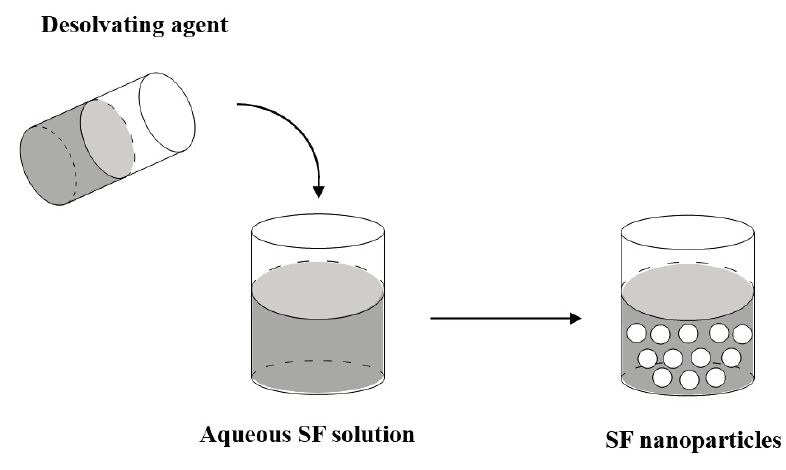
Figure 1. Schematic diagram of the desolvation method for preparing silk fibroin (SF) nanoparticles. Zhang et al. [45] reported the preparation of the SF nanoparticles by mixing the aqueous SF and water miscible protonic organic solvents (methanol, ethanol, propanol and isopropanol) or polar aprotonic organic solvents (tetrahydrofurnan and acetone). In this process, the regenerated SF molecules were instantly converted from Silk I into Silk II. When the aqueous SF was introduced rapidly into acetone, the water-insoluble SF nanoparticles with β -structure and a range of 35~125 nm in diameter could be